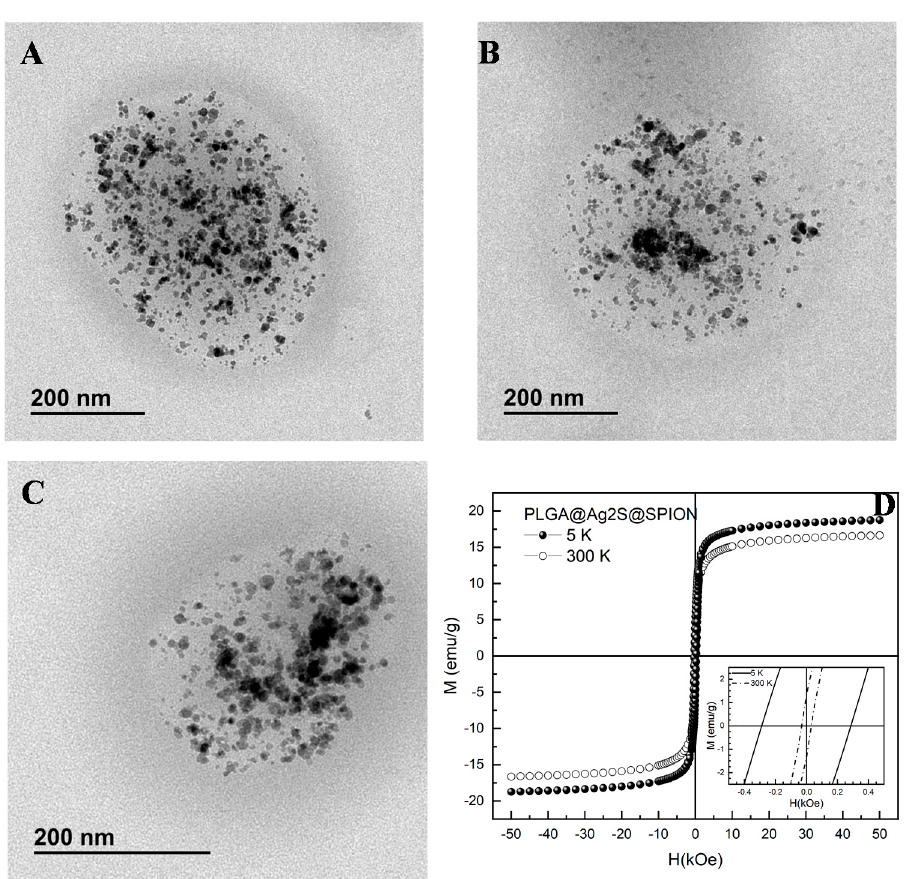
Figure 5. Representative TEM images for the hybrid PLGA@Ag 2 S@SPION_R4 system. ( A – C ). Mag- netization as a function of the applied field at 5 and 300 K (filled and empty squares respectively) for PLGA@Ag 2 S@SPION_R4. Inset represents the low field region to evaluate the coercive fields at 5 and 300 K (straight and dashed lines respectively) ( D ).